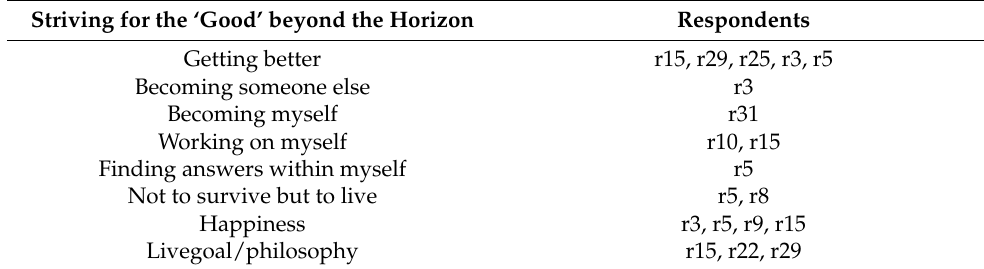
Table 5. Sources of ‘fulness’ that respondents aspire to in the first life